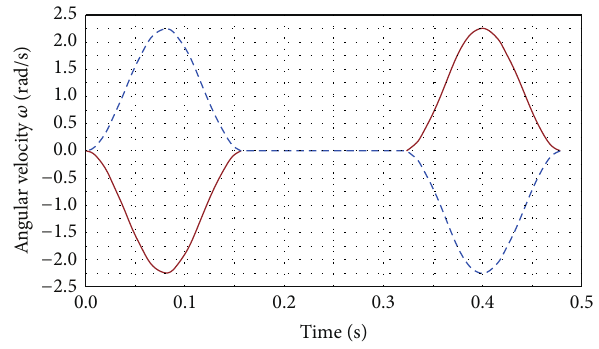
Figure 7: The angular velocity of BC and B 󸀠 C 󸀠